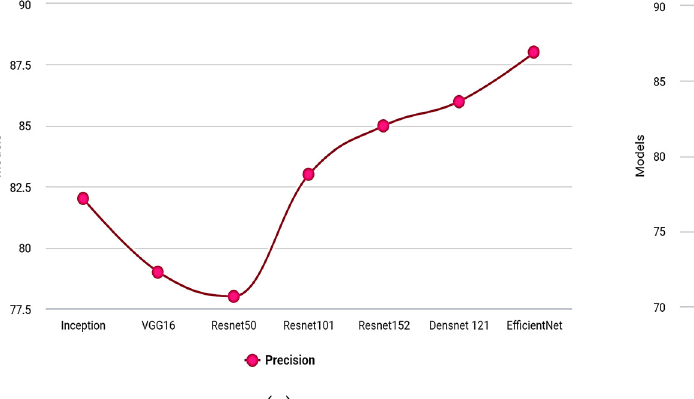
Table 6. Comparison analysis of the proposed model under Precision, Recall, and F1-score. Models